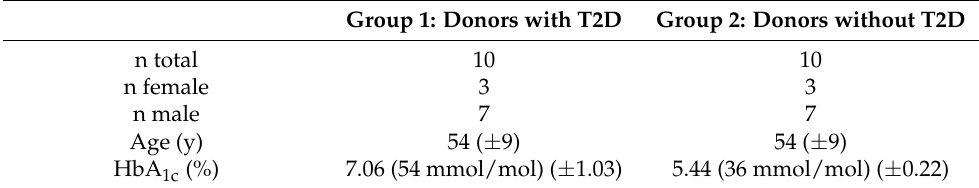
Table 1. Demographic data of the 10 donors with type 2 diabetes and the 10 non-diabetic donors. Values are expressed as mean ( ±